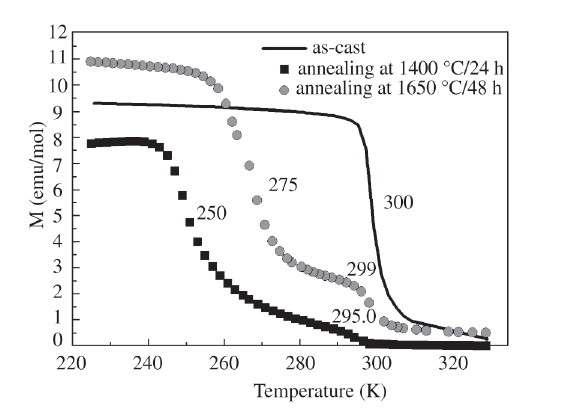
Figure 2. Comparison between the M vs. T curves at H = 200 for the as-cast and heat-treated